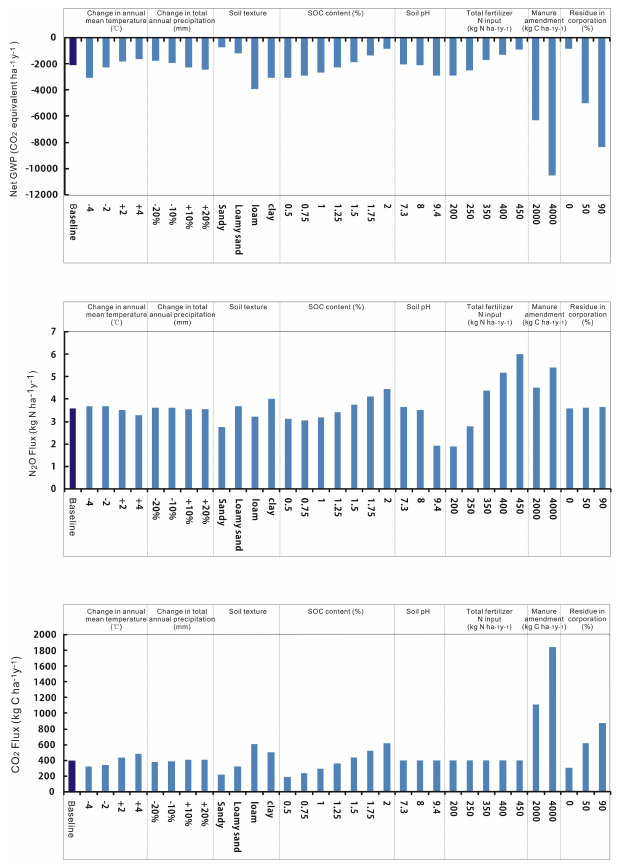
Fig. 7. Sensitivity of net GWP, N 2 O flux and CO 2 flux to change of each of the following factors: climate, soil and management.